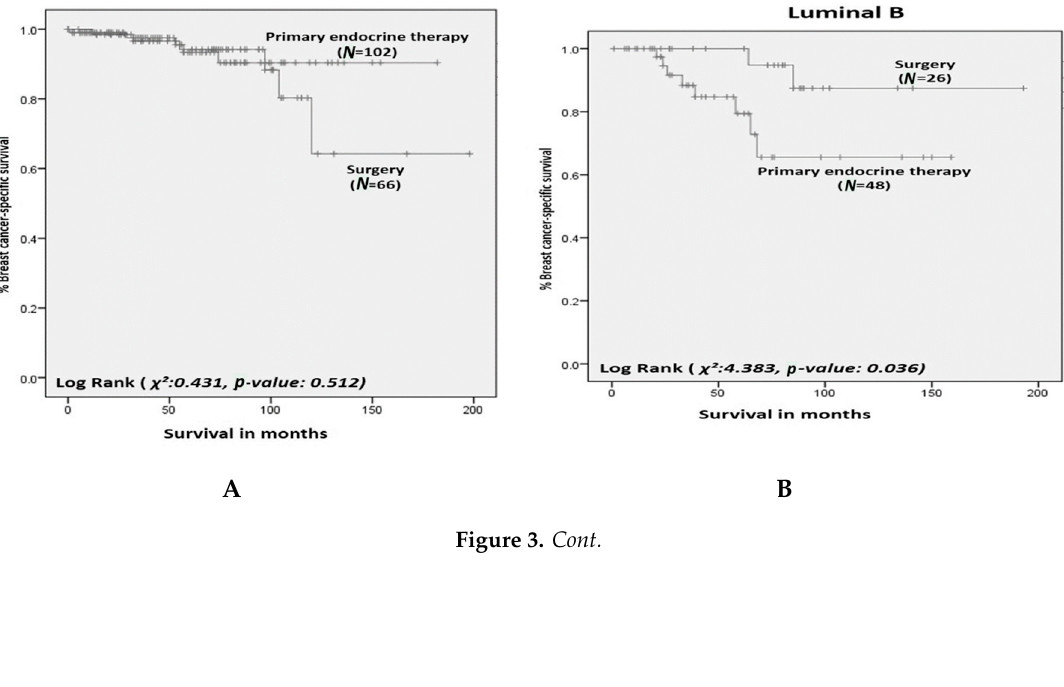
C Figure 3. Older women with oestrogen receptor positive primary breast cancer: breast-cancer-specific survival of biological clusters ( A ) luminal A, ( B ) luminal B, and ( C ) Low-ER luminal according to surgery versus primary endocrine therapy. In contrast for patients in luminal B cluster, BCSS was better in patients treated with surgery compared to PET ( p = 0.036).